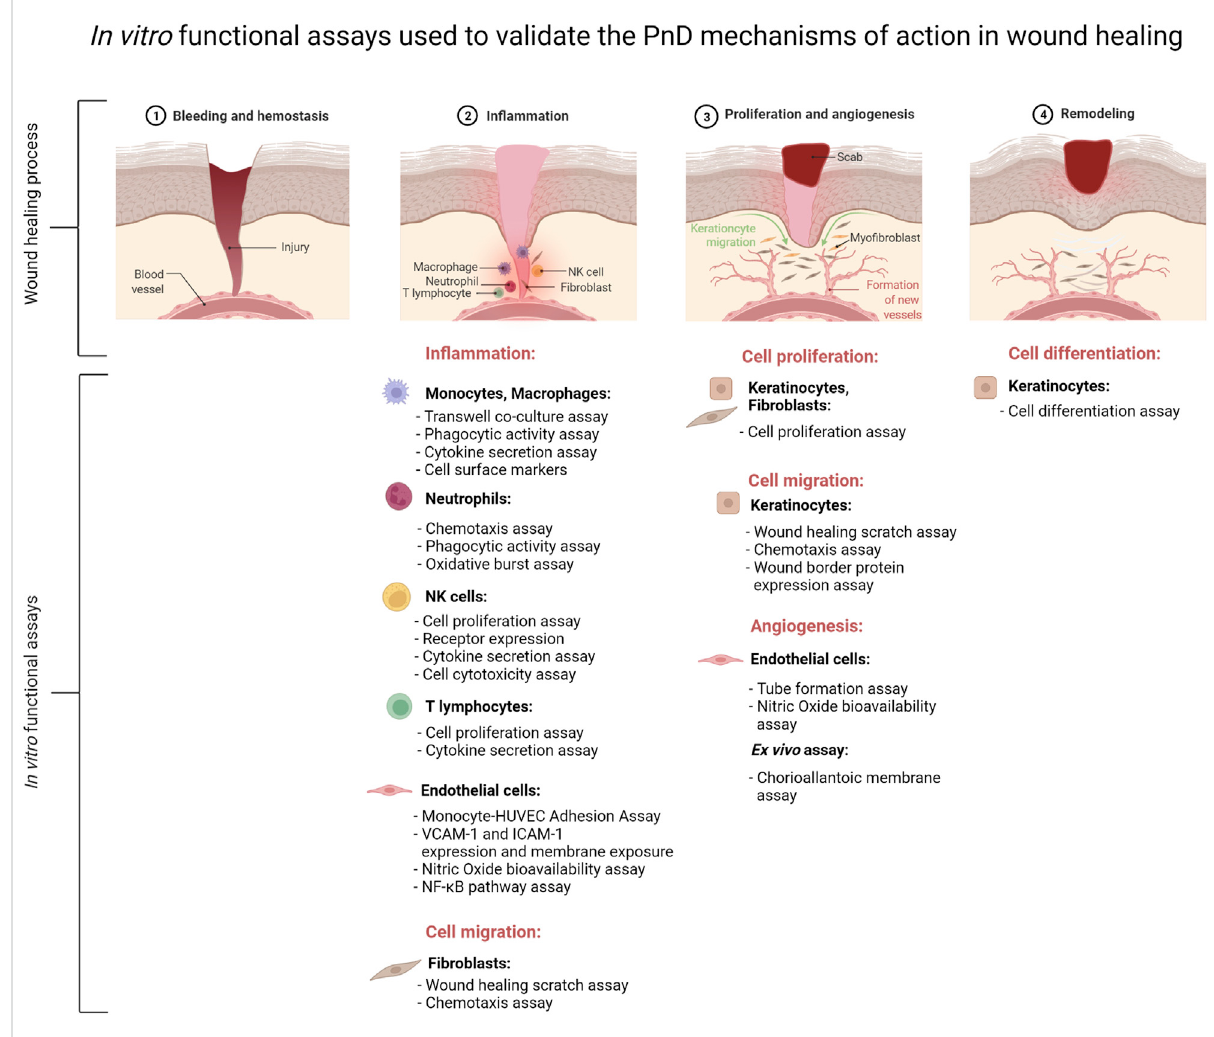
FIGURE 2 Schematic presentation of the major in vitro functional assays performed to validate the mechanisms of action of perinatal derivatives (PnD) in the context of in fl ammation, angiogenesis and remodeling during the complex process of wound healing. The fi gure was created using